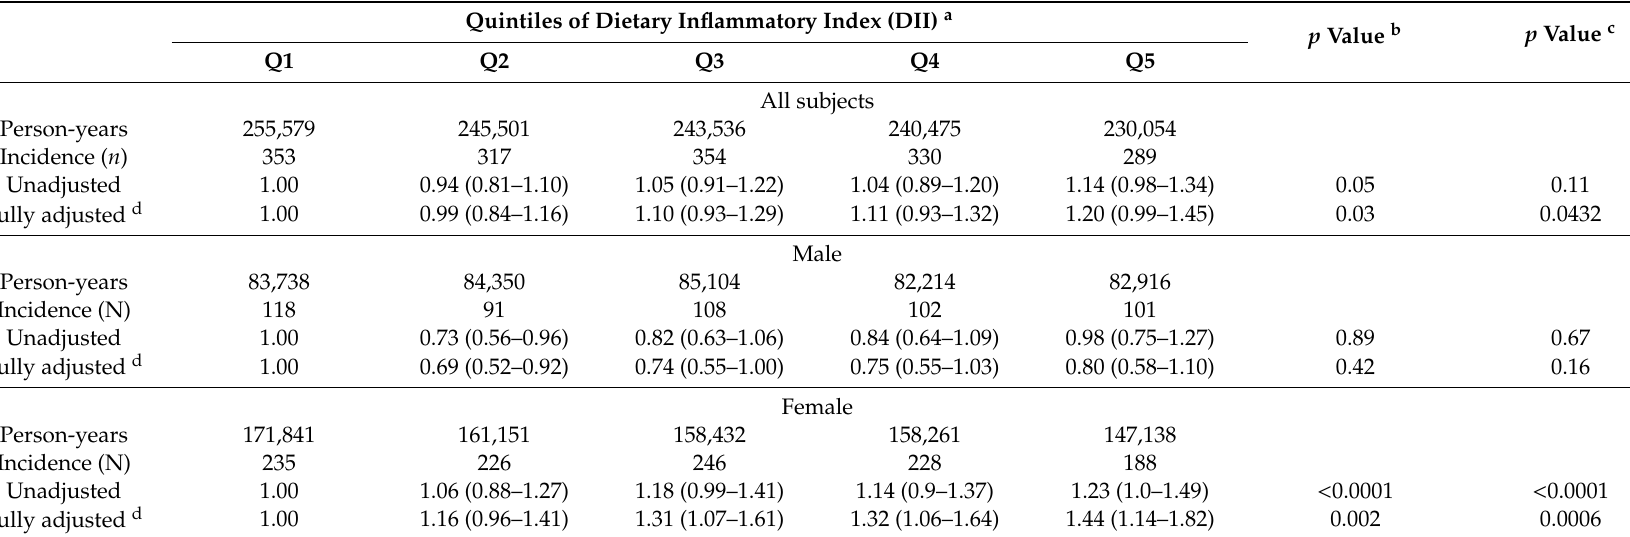
Table 2. Cox proportional Hazard Ratios (HRs) with 95% Confidence Intervals (CIs) for incidence of cancer expression according to Dietary Inflammatory Index (DII), KoGES